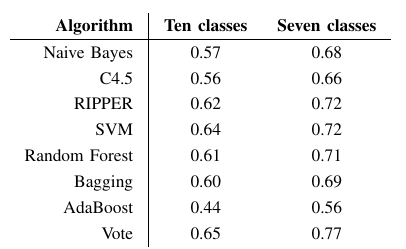
TABLE I: Classification accuracy of recognizing lifestyle